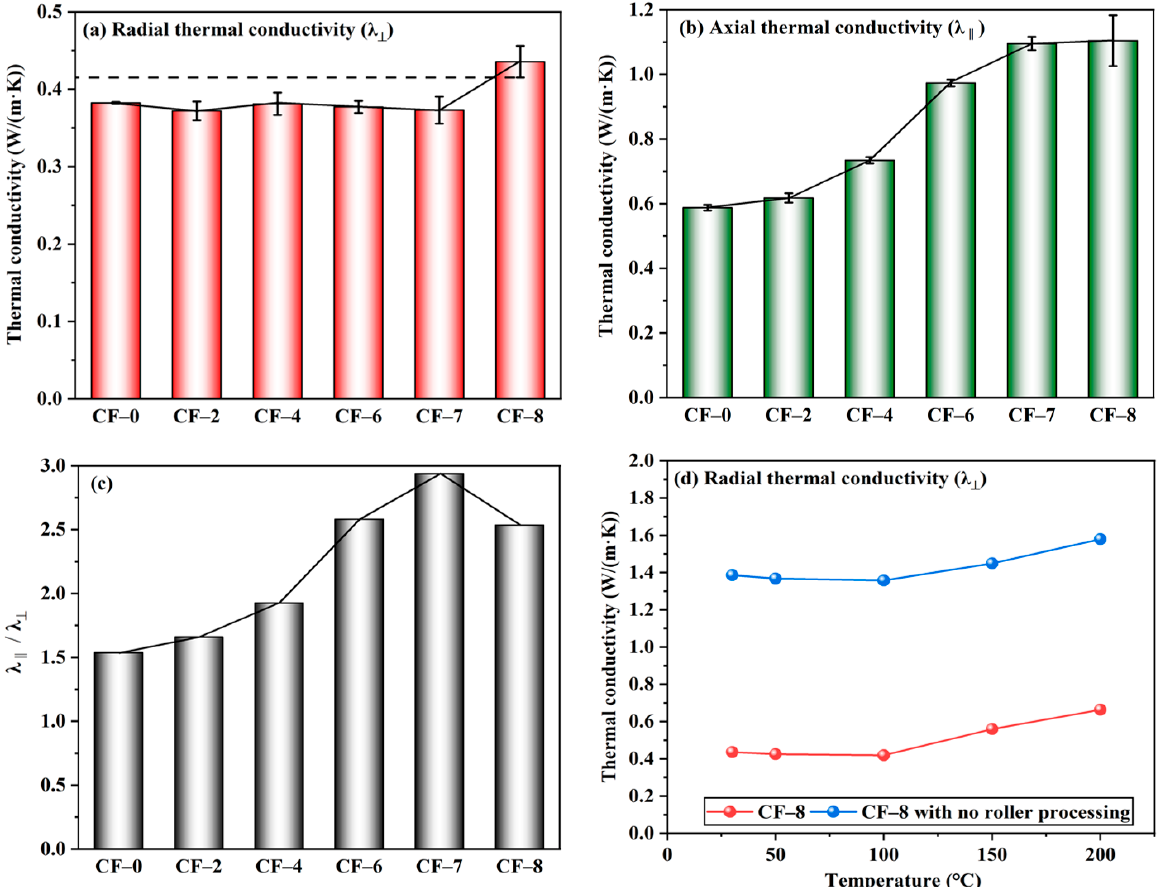
Figure 4. Radial thermal conductivity λ ⊥ ( a ), axial thermal conductivity λ ‖ ( b ), and λ ‖ / λ ⊥ ( c ) of multilayer CF@(CNT/Fe 3 O 4 )/EP-CFs composite, λ ⊥ comparison of roll treatment ( d ). The difference between λ (cid:107) and λ ⊥ indicates that the CFs core sheath and (CNT/Fe 3 O 4 )/ EP have influence on the thermal anisotropy of multilayer CF@(CNT/Fe 3 O 4 )/EP-CFs composite, the larger value of λ (cid:107) / λ ⊥ , the more